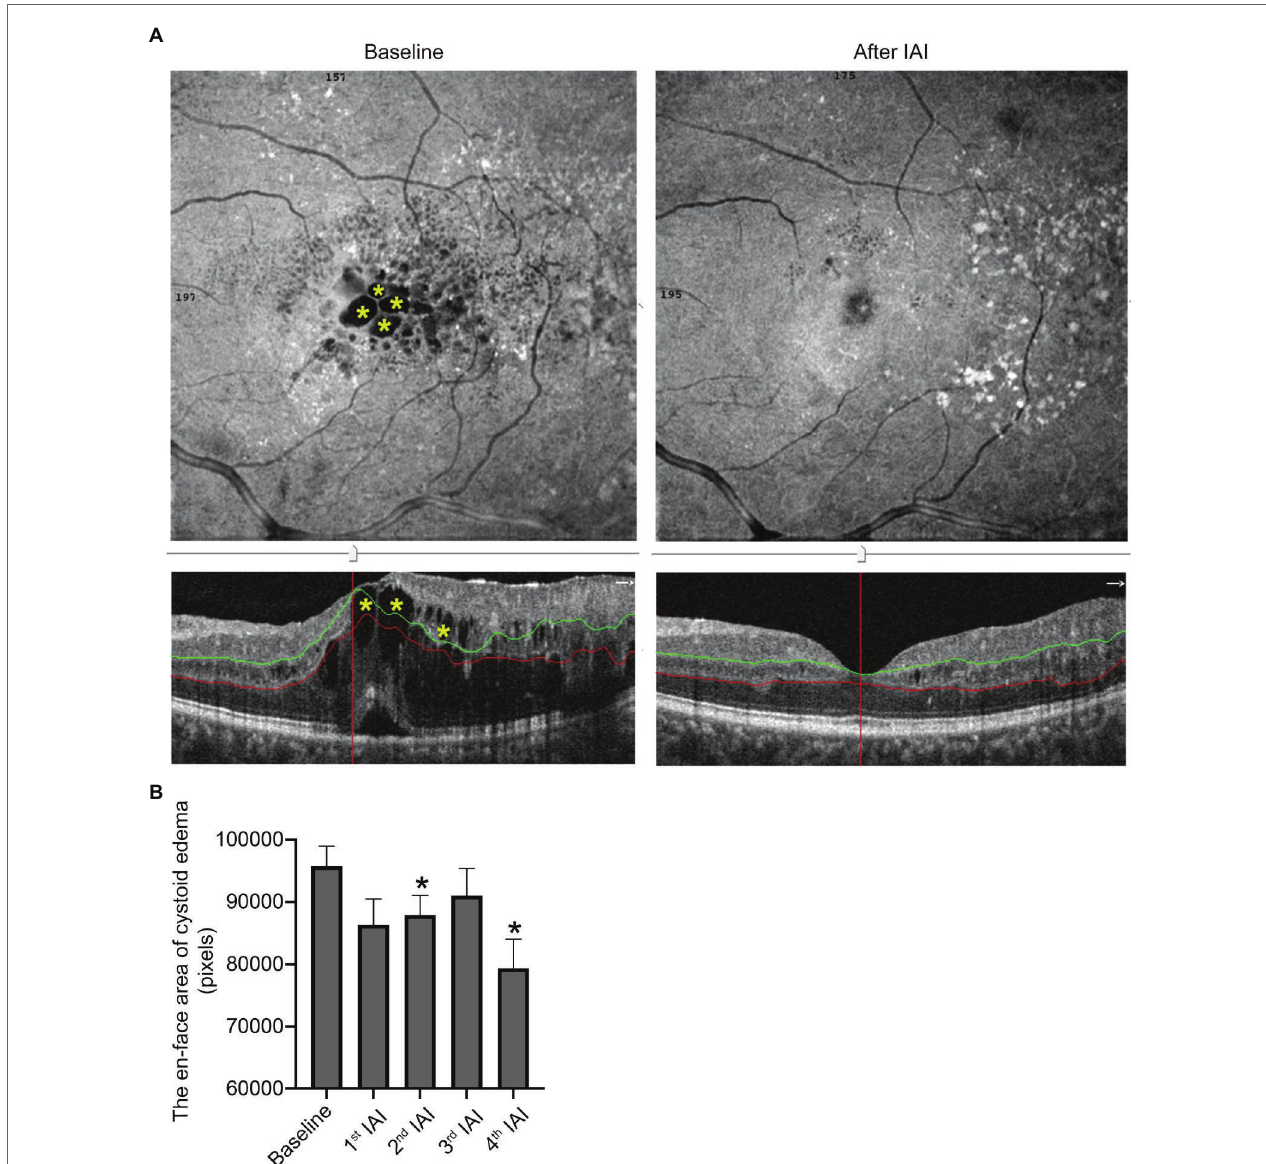
FIGURE 5 | The area of cysts in DCP is decreased after IAI. (A) Representative en-face and B-scan (yellow asterisk) OCTA images of an 84-year-old male patient with cystoid edema in DCP at baseline and after a monthly IAI. (B) Decreased en-face area of cysts in DCP following IAI. Data are mean ± SD. * p < 0.05 vs. baseline. DCP, deep capillary plexus; OCTA, optical coherence tomography angiography; and IAI, intravitreal aflibercept injection.